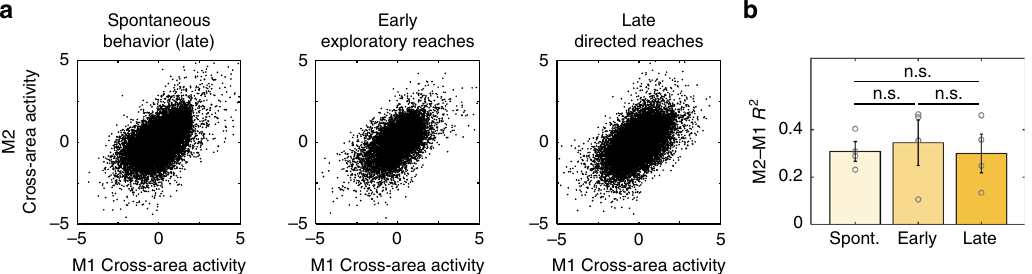
Fig. 3 Correlation of M1 – M2 cross-area activity is stable across behaviors. a Correlation between M2 and M1 components of the M2 – M1 cross-area population activity during (Left) spontaneous behavior, (Middle) early exploratory reaches, and (Right) late directed reaches. Spontaneous behavior was during the late learning day. Each data point is M2 and M1 data from a single 100 ms bin ( n = 4 rats). b Quanti fi cation of ( a ) as crossvalidated R 2 values. Bars show mean ± SEM, open circles show data from individual animals ( n = 4 rats). Correlation is not signi fi cantly different during spontaneous behavior, early reaches, and late reaches. Mixed-effect model, two-sided t -test, not adjusted for